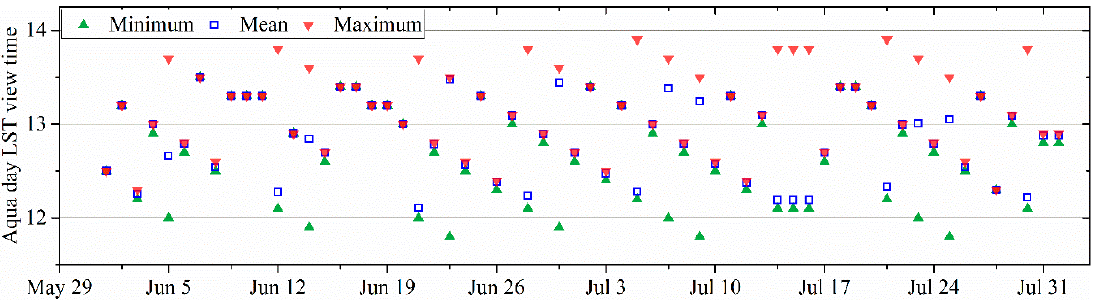
Figure 2. Local view time statistics of MODIS daytime LST on Aqua satellite over the SMAPVEX12 study area.